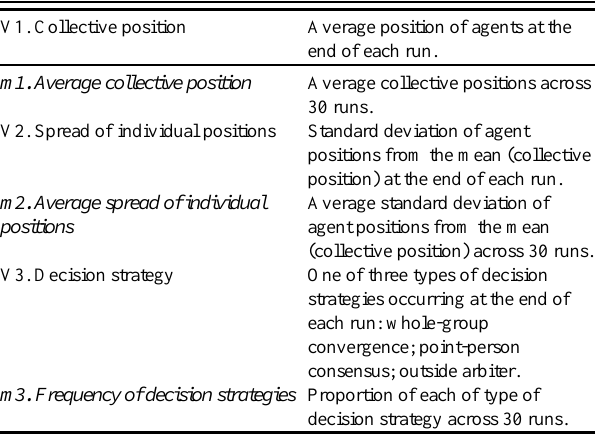
Table 2 . Output variables (V) and their associated metrics